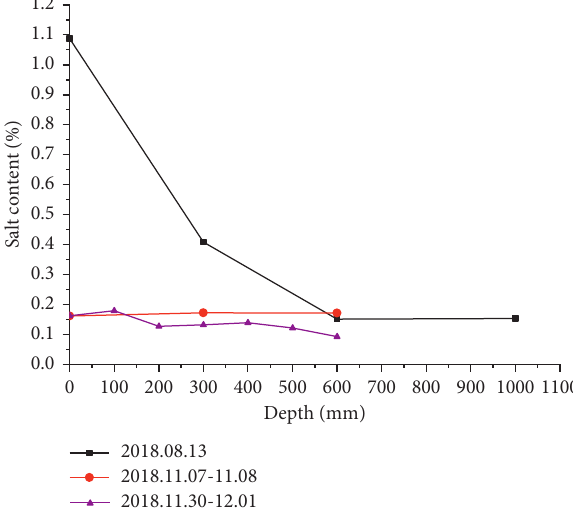
Figure 5: Relationship between salt content and depth of the saline-alkali soil.